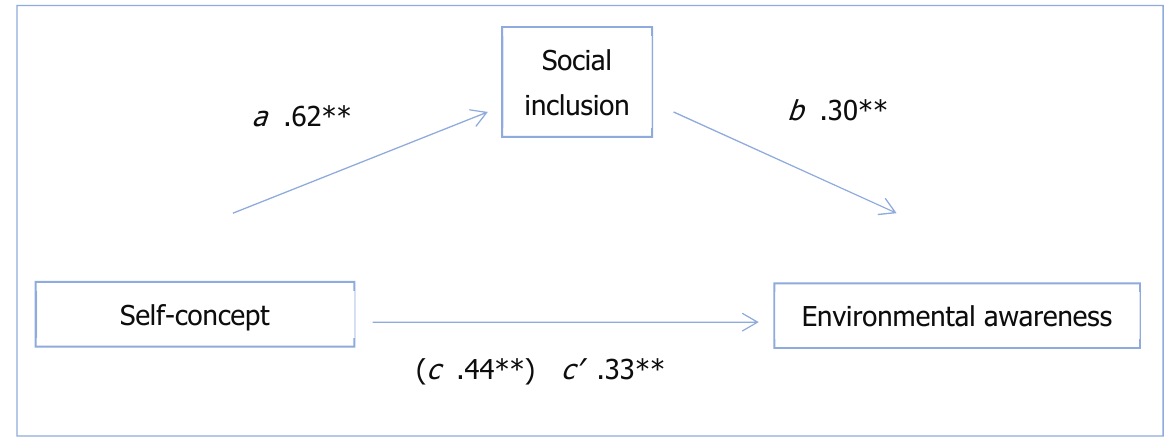
Figure 1. Association Between Self-Concept and Environmental Awareness Partially